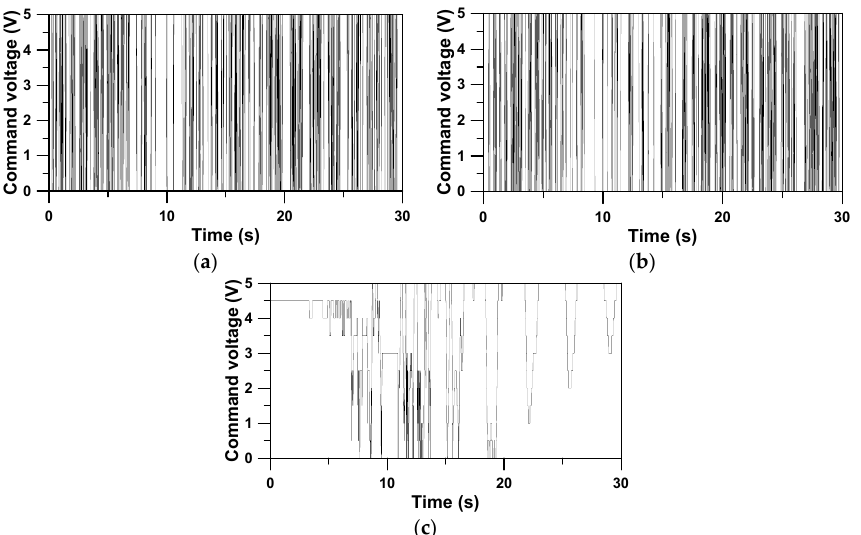
Figure 18. Time histories of command voltage (EV1): ( a ) groundhook algorithm, ( b ) skyhook algorithm, ( c ) DQN algorithm.